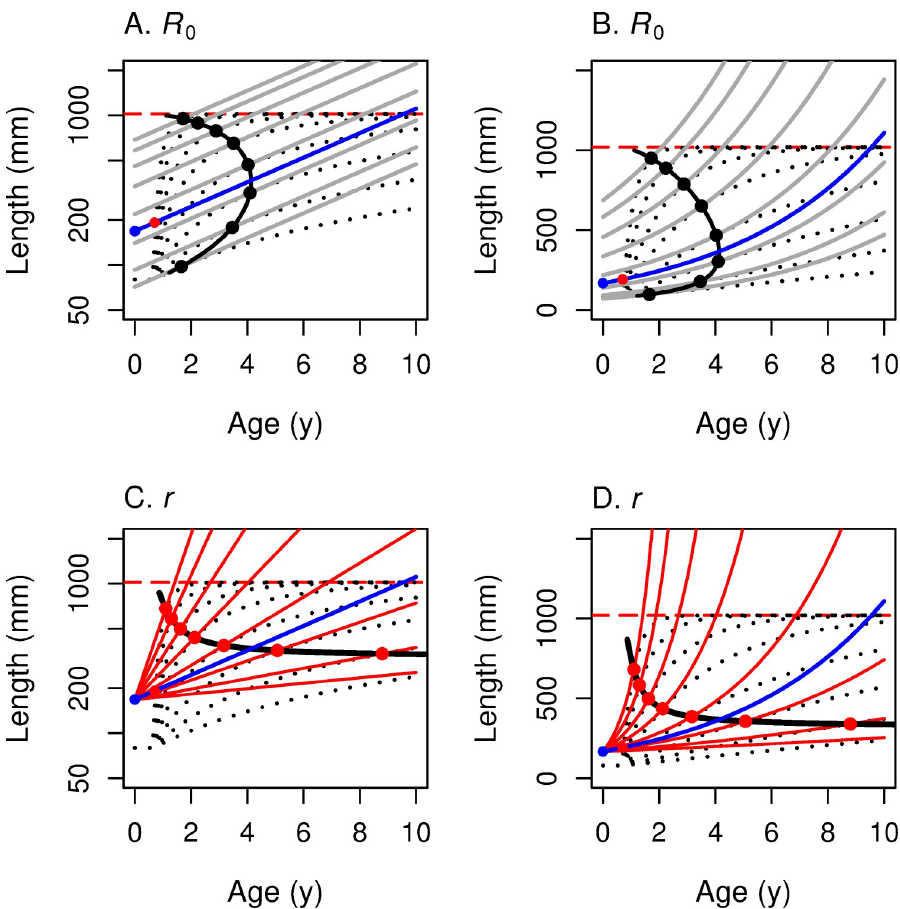
(A, B); r is the underlying fitness function for the bottom two (C, D). The y -axis corresponds to log-length in the two panels on the left (A, C) and to linear length in the two panels on the right (B, D). The graphs of the von Bertalanffy growth curves are represented by black dotted lines in all 4 panels. The iso-fitness curves (from Fig 1) are solid grey lines in the top 2 panels and solid red lines in the bottom two. For each growth curve, one finds the highest iso-fitness curve that intersects it. The locus of such points, as growth varies, traces out the MRN (solid black curve). In the top two panels the MRN( R 0 ) is a vertical line bowed to the right; in the bottom two panels the MRN( r ) is mostly horizontal. The blue curve marks the R 0 = 1 or r = 0 iso-fitness